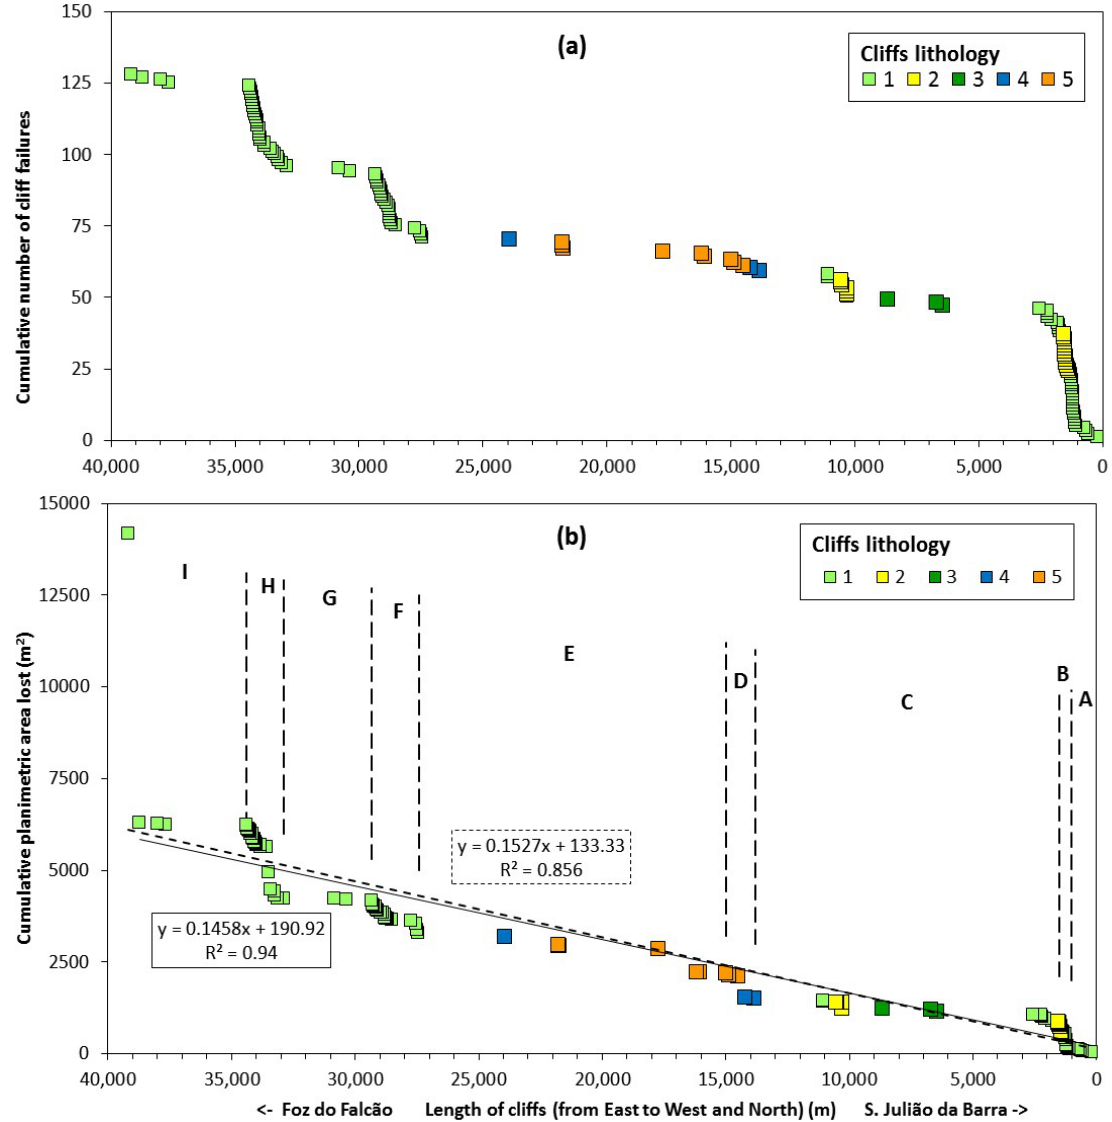
Figure 2. ( a ) Space distribution of number of cliff failures along cliff length, from the SE end of the study area ( left ) to the northern end ( right ) with colors indicating cliff failures lithology. ( b ) Space distribution of cumulative planimetric area lost at the cliff top caused by failures, along cliff length, with the limits of cliff sectors considered for cliff retreat computing (A to I, see text and Table 1). Regression lines and the equations slopes are measures of global cliff retreat rate, considering all failures (doted lines) and not considering the large translational failure at the northern end of the study area (plain lines). Main lithology of cliff failures: 1—Marls and limestones; 2—Sandstones and